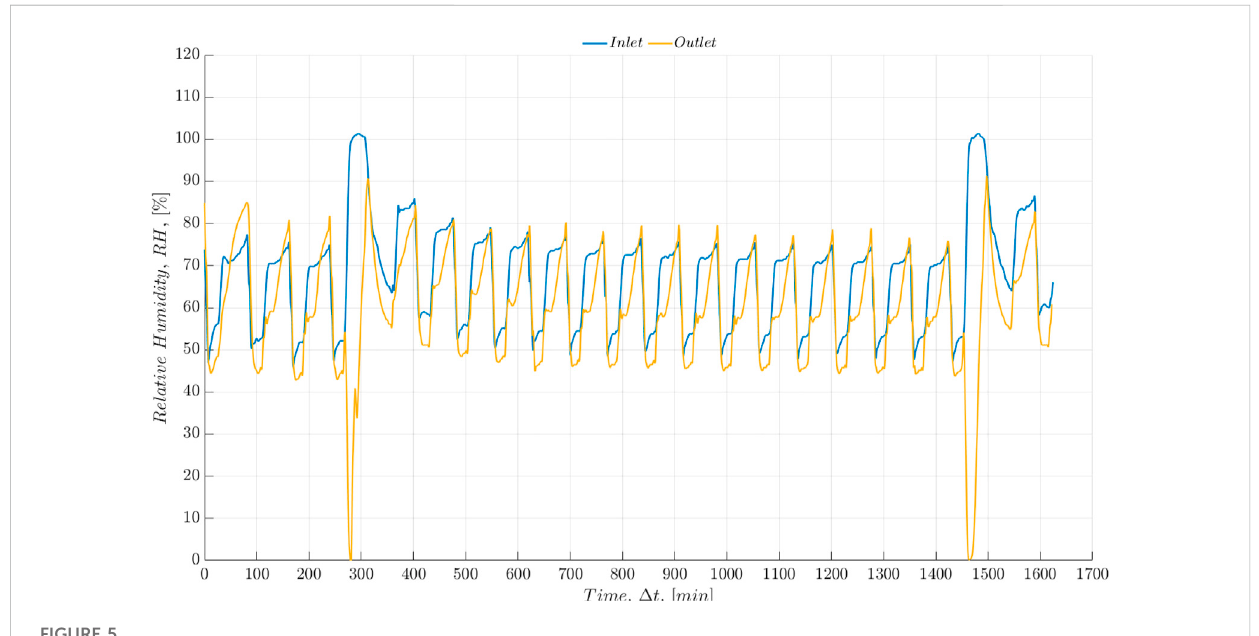
FIGURE 5 Refrigeration system